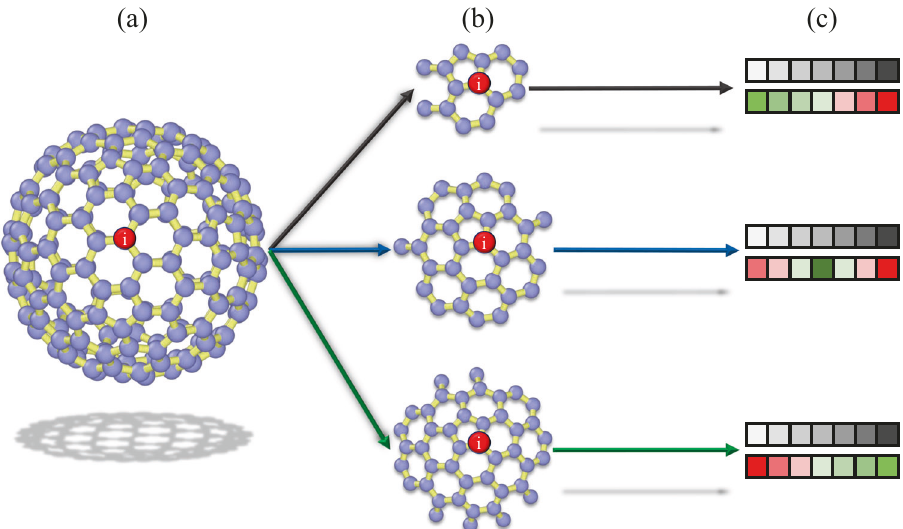
Fig. 9 Visualization of the VGOP framework. a A 180-atom buckyball is shown, with a speci fi c atom i highlighted in red. b Three substructures of the buckyball, determined by selecting atoms varying cutoff radii away from atom i , that form the basis of unique GCNs. c Three sets of two bars, which each subset representing the degree set (top) of each GCN and the degree probability set (bottom). The colors of the degree set are de fi ned as white representing low connectivity and black representing high connectivity. The colors of the probability set are speci fi ed as green representing high likelihood and red representing low likelihood of occurrence in the GCN. The varying colors of the probability sets indicate that the smallest substructure in ( b ) yields a large number of poorly connected nodes and little-to-no high connectivity, while the opposite is true for the largest substructure in ( b